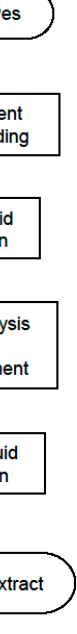
Figure 2. Flowchart of the production of olive leaf extracts that are rich in HT.